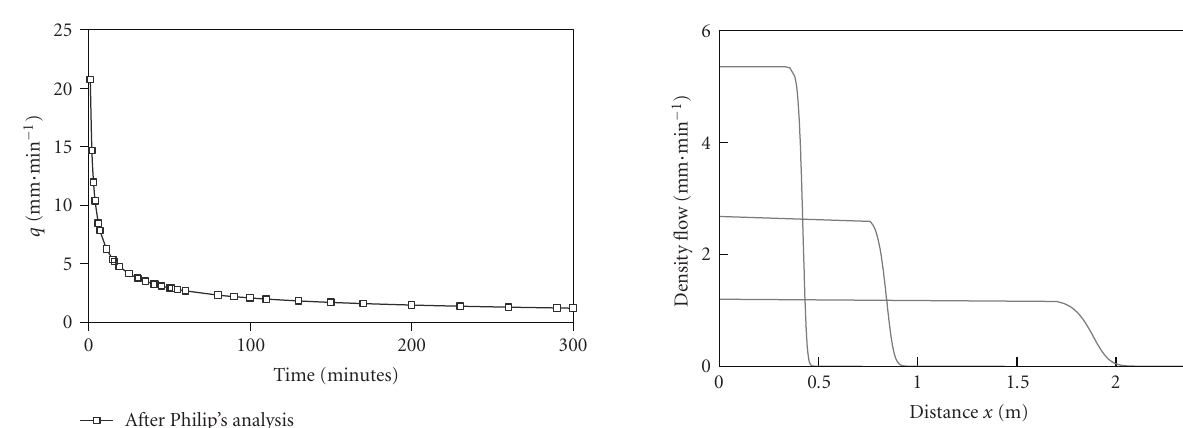
Figure 1: Water density flow into the soil ( x = 0) as a function of the time for horizontal infiltration in homogeneous marine sand, according to (34) or (44).